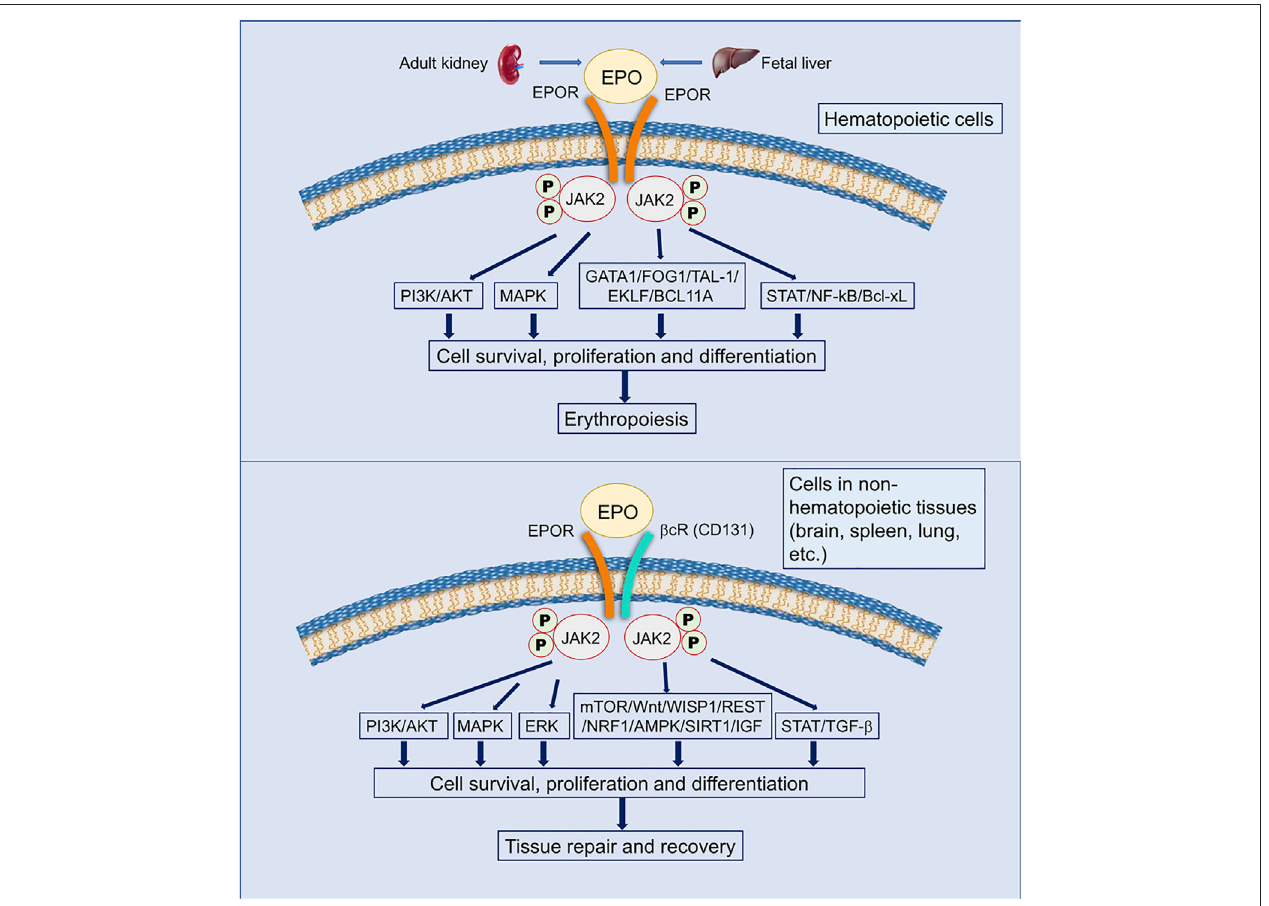
FIGURE2| EPO and EPO receptors. EPO hasbeen demonstratedto interact with twoclassicreceptorstoinitiate its pleiotrophic effects. Ahomodimericreceptor withtwounitsofEPOR(yellowstructures)isexpressedonhematopoieticcells,whileaheterodimericreceptorwithoneEPORandone β cR(CD131)unit(yellowandcyan structure)isexpressedoncellsinnon-hematopoietictissuessuchasthebrain,spleen,andlungs.EPOactivatesdifferentintracellularpathwaysthroughEPORs,leading to anti-apoptotic gene expression and the inhibition of pro-apoptotic genes. These actions allow for cell survival, proliferation, and differentiation. Activation of the homodimericEPOR/EPORleadstoerythropoiesis,whileactivationoftheheterodimericEPOR/ β cR(CD131)leadstotissuerepairandrecovery(Socolovskyetal.,2001; Tsiftsoglou, 2021; Maiese, 2015; Gyetvai et al., 2017; Othman et al., 2018; Jarero-Basulto et al., 2020; Peng et al., 2020; Jacobs et al., 2021; Larpthaveesarp et al., 2021). The JAK/STAT (Janus kinase/signal transducer and activator of transcription) pathway is involved in many vital cellular processes, including cell growth, differentiation, proliferation, and regulatory immune functions; PI3K/AKT (Phosphatidylinositol-4,5-bisphosphate 3-kinase/protein kinase B) is activated by numerous genes and improves cell proliferation during erythropoiesis in hypoxia; ERK/MAPK (extracellular signal-regulated kinase/Mitogen-activated protein kinase) is the key signaling pathway that regulates a wide variety of cellular processes, including proliferation, differentiation, apoptosis, and stress responses; GATA1, FOG1, TAL-1, and EKLF (Erythroid Kruppel-like Factor, also called KLF1) are master transcriptional regulators of erythropoiesis; BC11A, transcriptional repressor B-cell lymphoma/ leukemia 11A, is a transcriptional repressor of erythropoiesis; TGF- β , transforming growth factor- β , regulates cell growth and differentiation, apoptosis, etc.; NF-kB, the nuclearfactorkB,couldregulatetheexpressionofgenesinvolvedincellproliferation,migration,andapoptosis;Bcl-xL,B-celllymphomaextra-large,isananti-apoptotic Bcl-2 protein; mTOR, mammalian target of rapamycin, is a protein kinase regulating cell growth, survival, metabolism, and immunity; Wnt, wingless-type, the ligand of Wnt-signaling, are unique directional growth factors that contribute to both cell proliferation and polarity; WISP1, Wnt1-inducible signaling pathway protein 1, a target of Wnt1, mediates cell proliferation and apoptosis, etc.; REST, the repressor element 1-silencing transcription, is a repressor of neuronal genes during embryonic development and regulates a network of genes that mediate cell death in the aging human brain (Lu et al., 2014); NRF1, nuclear factor erythroid 2-related factor-1, is a endoplasmic reticulum-bound transcription factor that regulates protein homeostasis; AMPK, AMP-activated protein kinase, plays a major role in regulating cellular energy balance; SIRT1, silent information regulator 2 homolog 1, is a protein deacetylase that mediates cell self-renewal; IGF, insulin-like growth factor, induces the signaling networks, which are vital in modulating multiple fundamental cellular processes, such as cell growth, survival, proliferation, and differentiation.